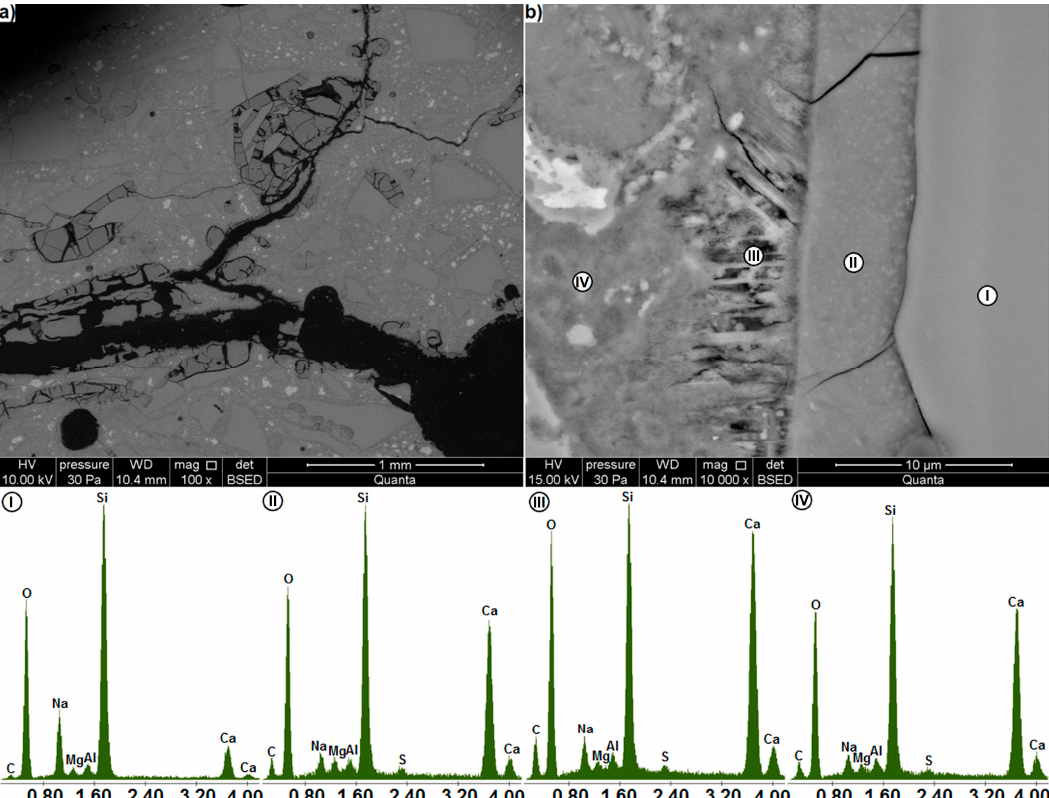
Figure 11. Microstructure of the mortar containing waste glass as examined on a thin section (BSE) ( a ) area around a large crack, ( b ) glass-paste interfacial zone; EDS analysis at points I, II, III and IV. As in Figure 9, a densely cracked area of mortar containing waste glass is visible in Figure 12a.